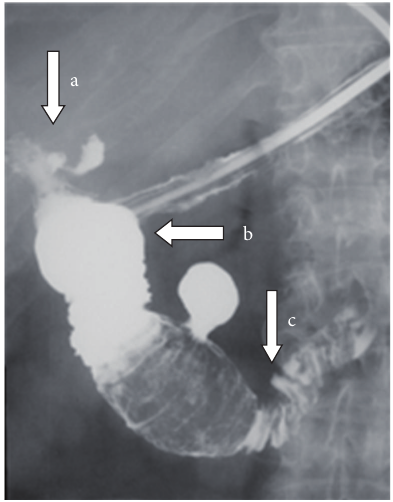
Figure 7: Fifteen minutes after intake of the oral contrast (a) the evacuation of the gallbladder is well seen as well as (b) the dilatation of the filled up with contrast duodenum proximally to the impacted gallstone and (c) the slight passage of the gastrografin distally to the gallstone in the 4rth part and jejunum.